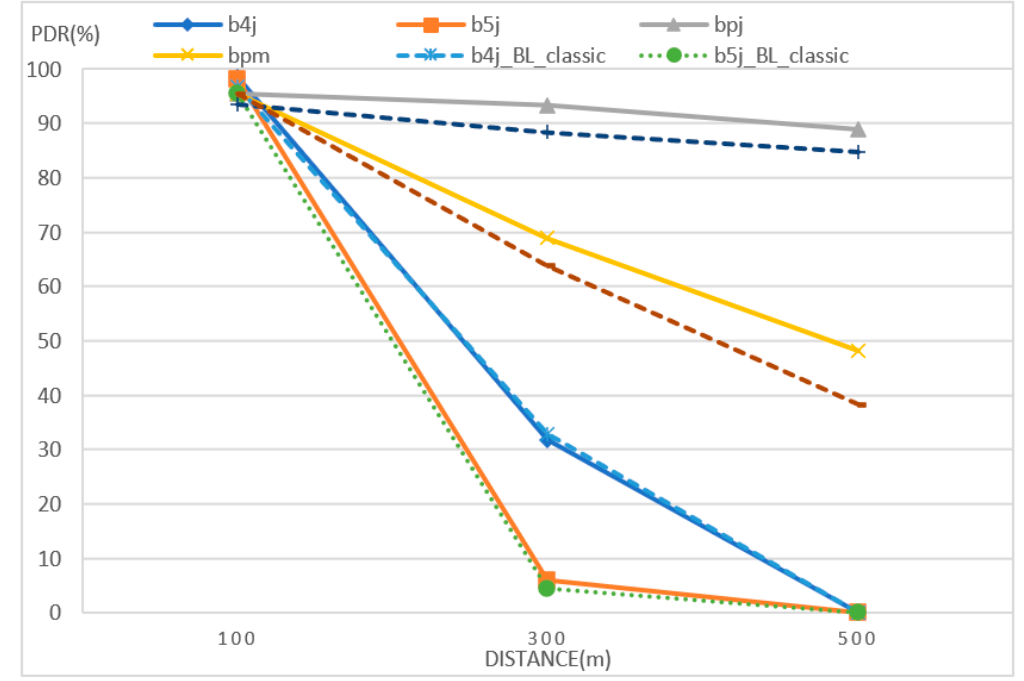
Figure 14. PDR(%) results comparing normal operation and Bluetooth Classic interference environments.